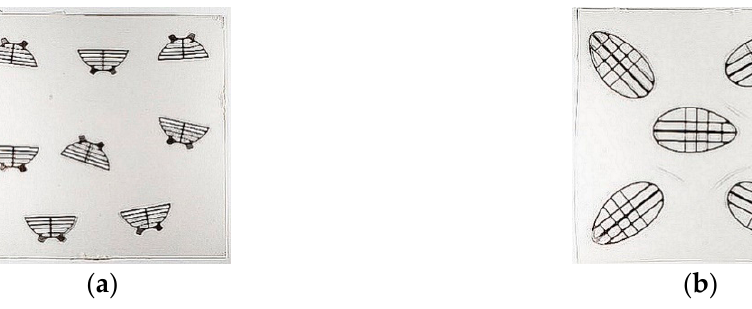
Figure 10. Foils with sti ff ening frames made of titanium after pressure processing for ( a ) outflow and Figure 10. Foils with stiffening frames made of titanium after pressure processing for ( a ) outflow and Figure 10. Foils with stiffening frames made of titanium after pressure processing for ( a ) outflow and Figure 10. Foils with stiffening frames made of titanium after pressure processing for ( a ) outflow and ( b ) inflow valves, respectively. ( b ) inflow valves, respectively. ( b ) inflow valves, respectively. ( b ) inflow valves, respectively.